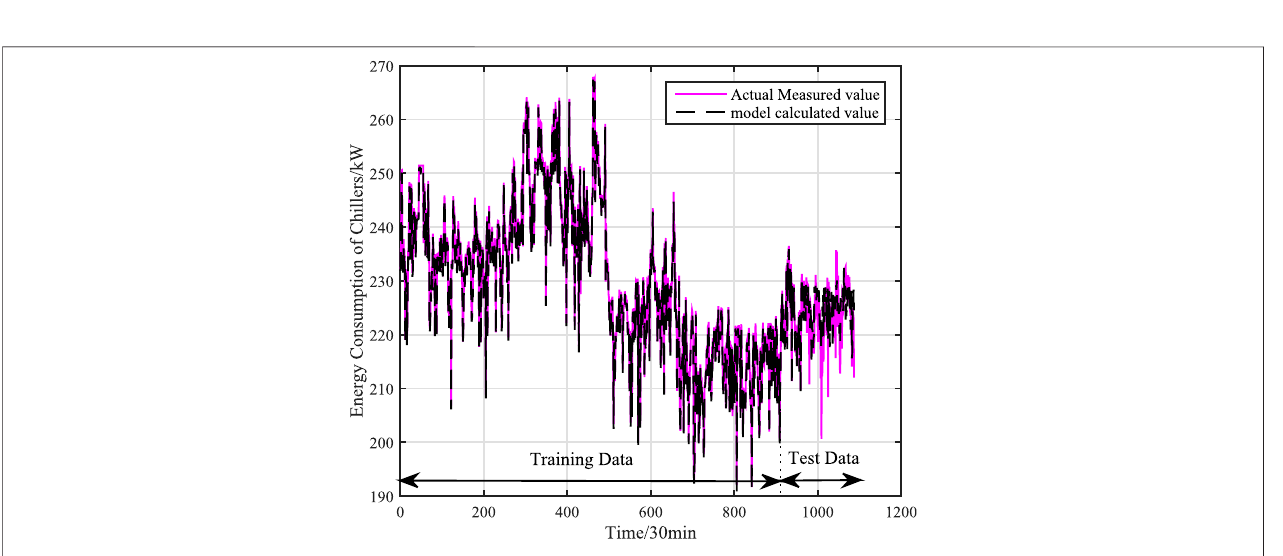
FIGURE 7 | Training and test results of KPLS model under single working condition (working condition 2).